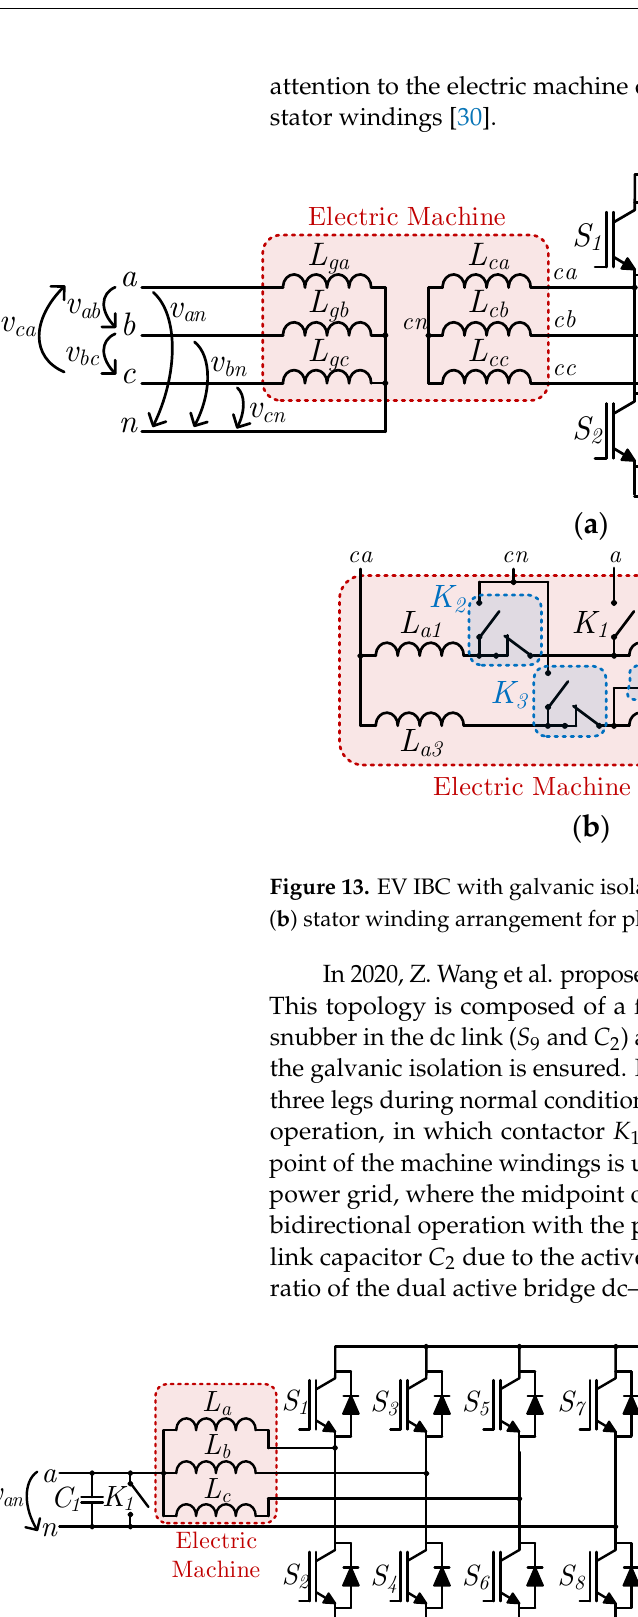
Figure 14. EV IBC with galvanic isolation proposed by Z. Wang et al. in 2020 [31].